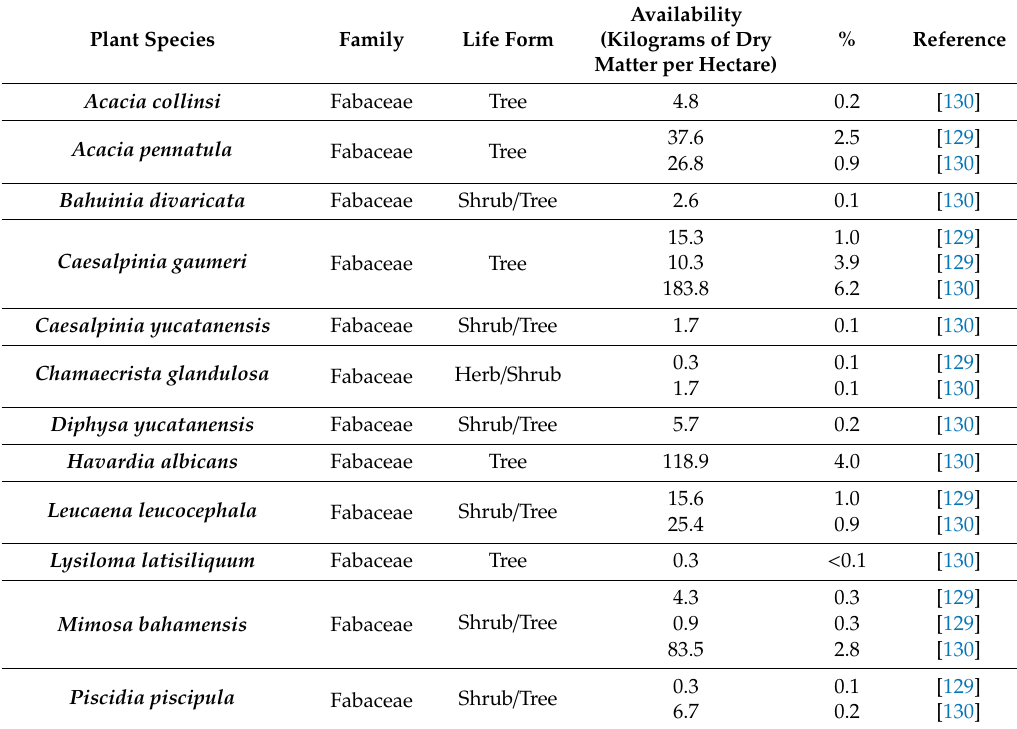
Table 3. Availability of edible plant feed resources for small ruminants during the rainy season in the Low Deciduous Forest of Yucat á n, M é